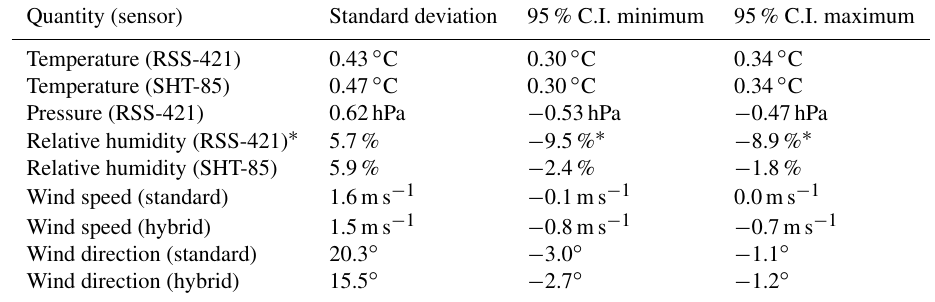
Figure 5. Example profiles from the DH2 deployment for the MOSAiC experiment in comparison with data from a nearby radiosonde launch. Included are (from left to right) air temperature, air pressure, relative humidity, wind speed, and wind direction. The example profile data are from 22 July 2020, where the DH2 profile began at 08:40UTC and where the radiosonde profile began at 07:56UTC. Note that, in this instance, the RSS-421 was not conditioned prior to flight, resulting in a significant low bias in relative humidity. Table 2. DH2 instrumentation or derived parameter difference from radiosonde data taken within an hour of a given data point. Quantity (sensor) Standard deviation 95% C.I.